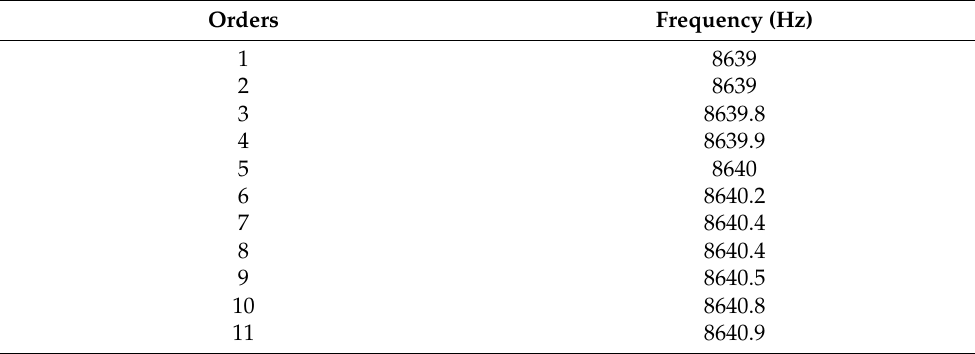
Table 6. The natural frequency under the constraint condition. Orders